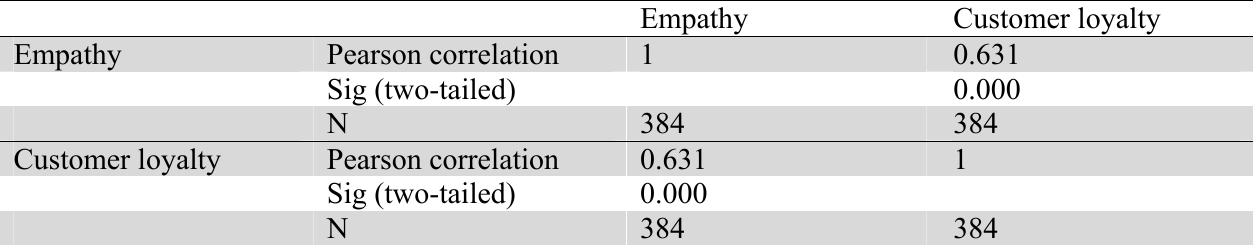
The result of Pearson correlation ratios